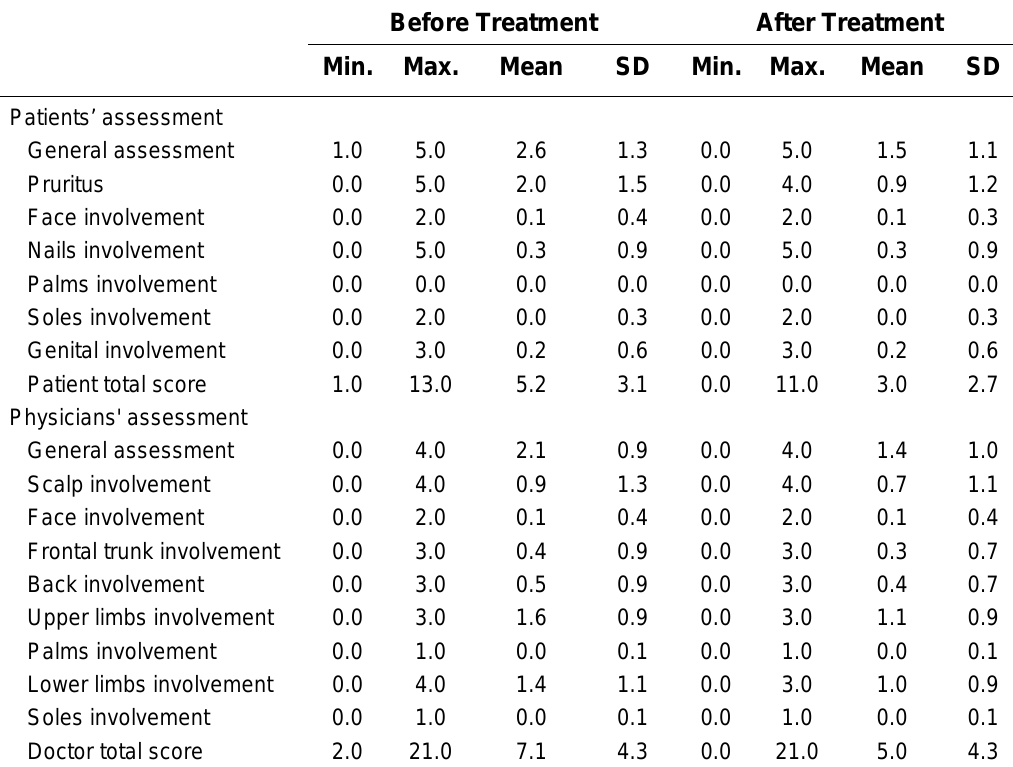
Assessment of Psoriasis Severity Before and After QoolSkin Treatment in 48 Patients Treated by AS Before